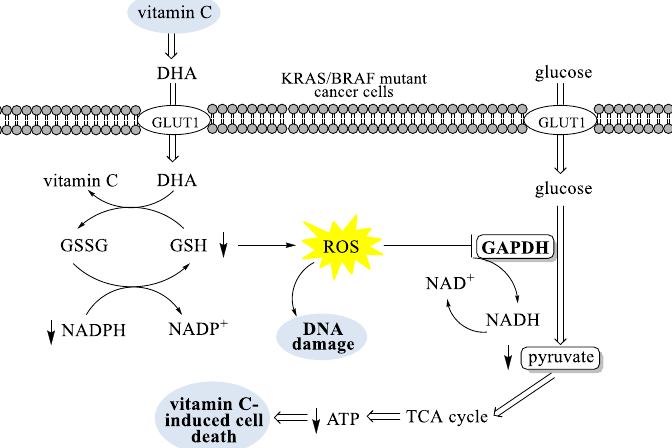
Figure 2. The mechanistic overview of vitamin C toxicity in cancer cells with KRAS and BRAF mutations. DHA: dehydroascorbic acid; GLUT1: glucose transporter 1; KRAS: kirsten rat sarcoma viral oncogene; BRAF: v-raf murine sarcoma viral oncogene homolog B; GSH: reduced form of glutathione; GSSG: oxidized form of glutathione; NADPH: reduced nicotinamide adenine dinucleotide phosphate; NADP + : nicotinamide adenine dinucleotide phosphate; ROS: reactive oxygen species; GAPDH: glyceraldehyde 3-phosphate dehydrogenase; NADH: reduced nicotinamide adenine dinucleotide; NAD+: oxidized nicotinamide adenine dinucleotide; TCA: citric acid cycle also known as the tricarboxylic acid or the Krebs cycle; ATP: adenosine 5 (cid:48)